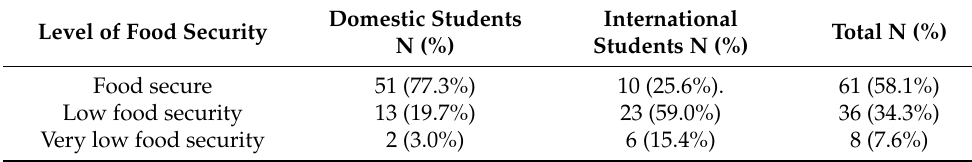
Table 4. Levels of food security (N = 105).